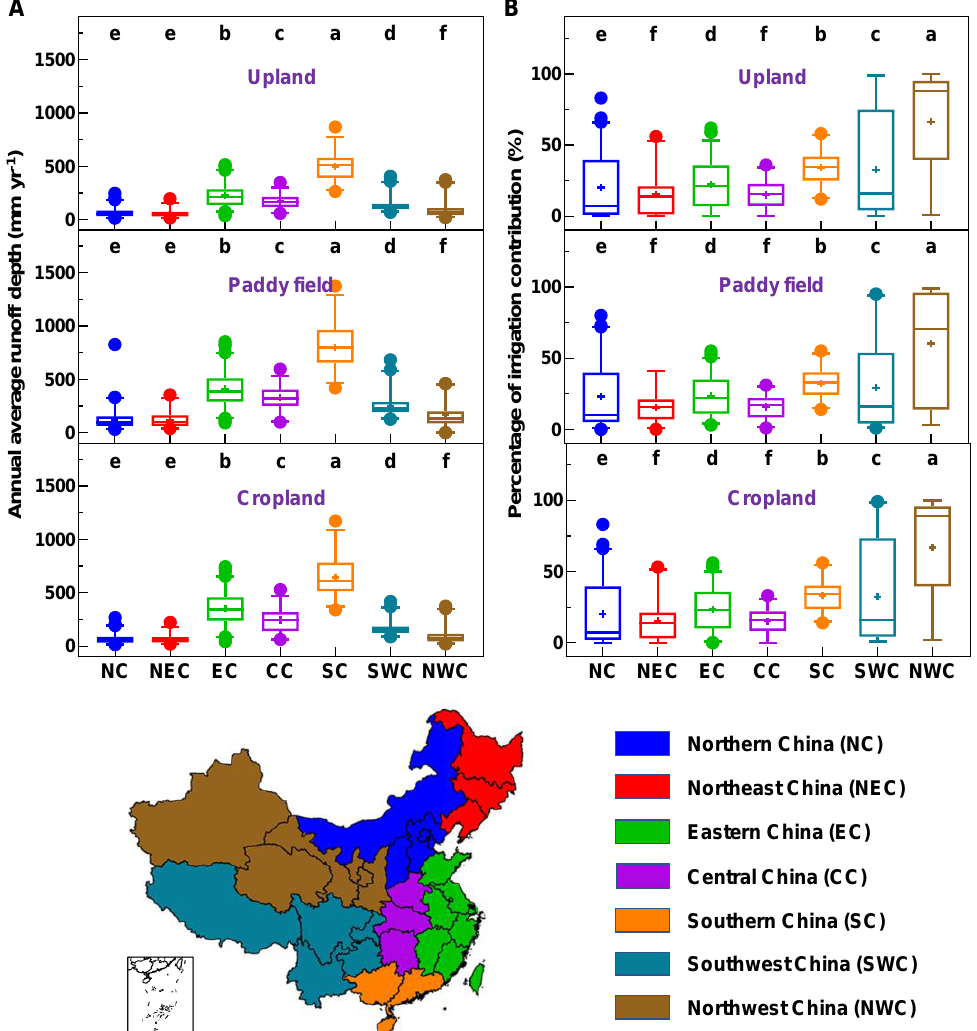
Figure 3. Spatial patterns of ( A ) annual average cropland runoff depth (different lowercase letters indicate that mean values are statistically different at p < 0.01), and ( B ) the irrigation-runoff percentages across seven geographical regions in China. Box plots illustrate the 25th, 50th and 75th percentiles; whiskers indicate the 2.5th and 97.5th percentiles; and points represent data outliers. The smaller map frame at the lower left corner represents the ten-dash line of Nansha Islands.